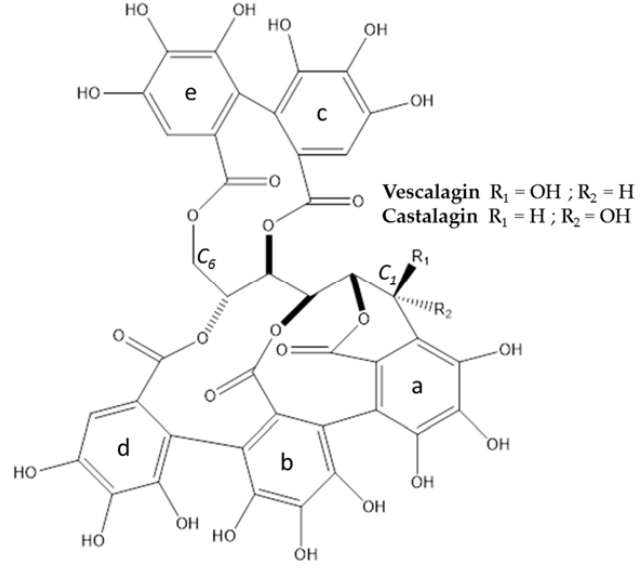
Figure 1. Structure of vescalagin ( 1 ) and castalagin ( 2 ).